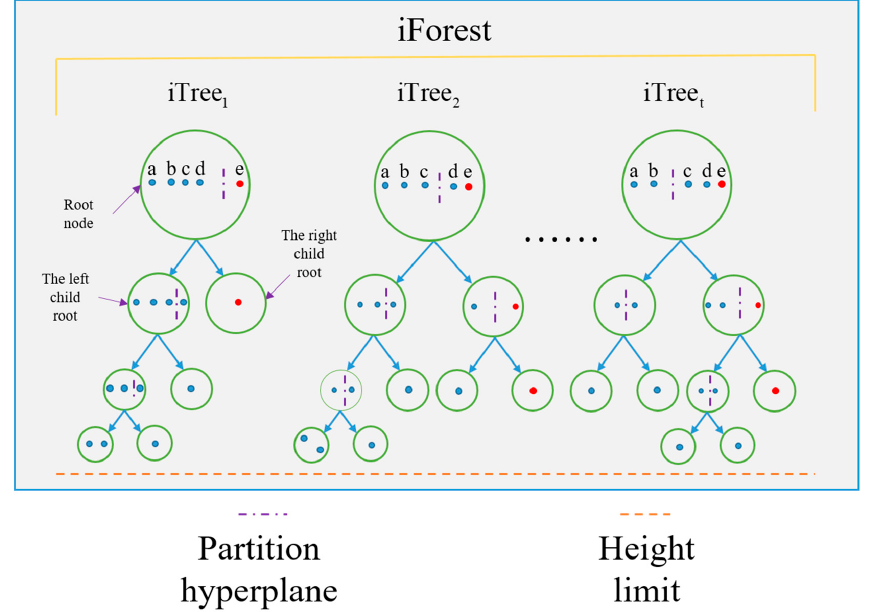
Figure 3. One-dimensional data used to demonstrate the principle of iForest.